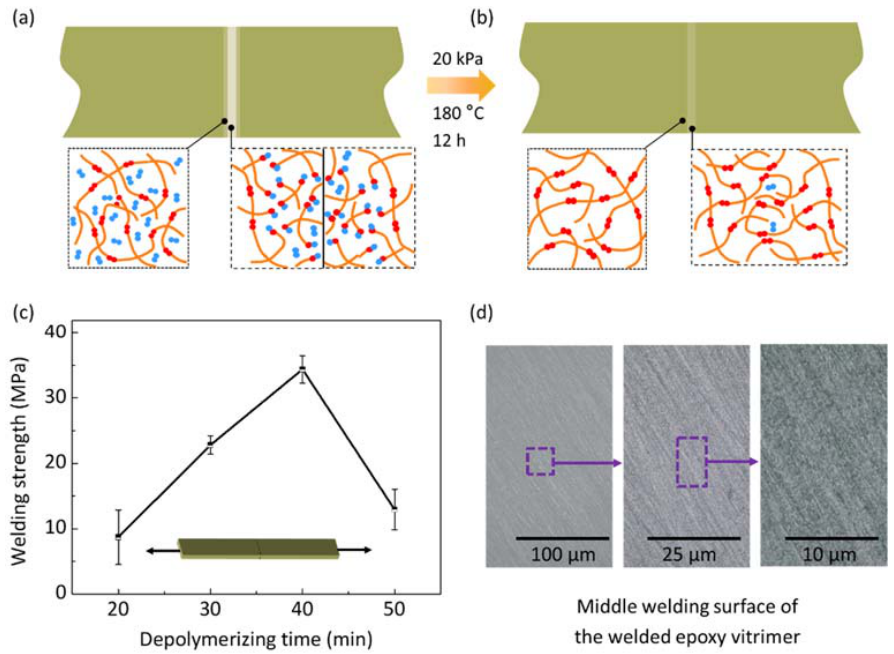
Figure 5. Effect of depolymerizing time on the welding performance of epoxy vitrimers. The vitrimer are welded under 20 kPa at 180 °C for 12 h. Schematic representation of the depolymerized vitrimers ( a ) before welding and ( b ) after welding. ( c ) The welding strength of the butt ‐ welded vitrimer versus depolymerizing time. Each data point represents the mean and stands deviation of three measurements. ( d ) The microscopical images of welded region with depolymerizing time of 40 min.